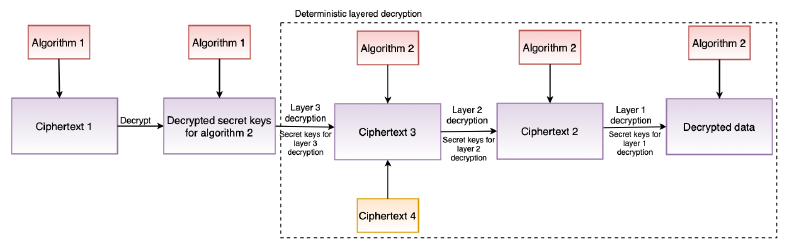
Figure 4. Architecture of decryption scheme.